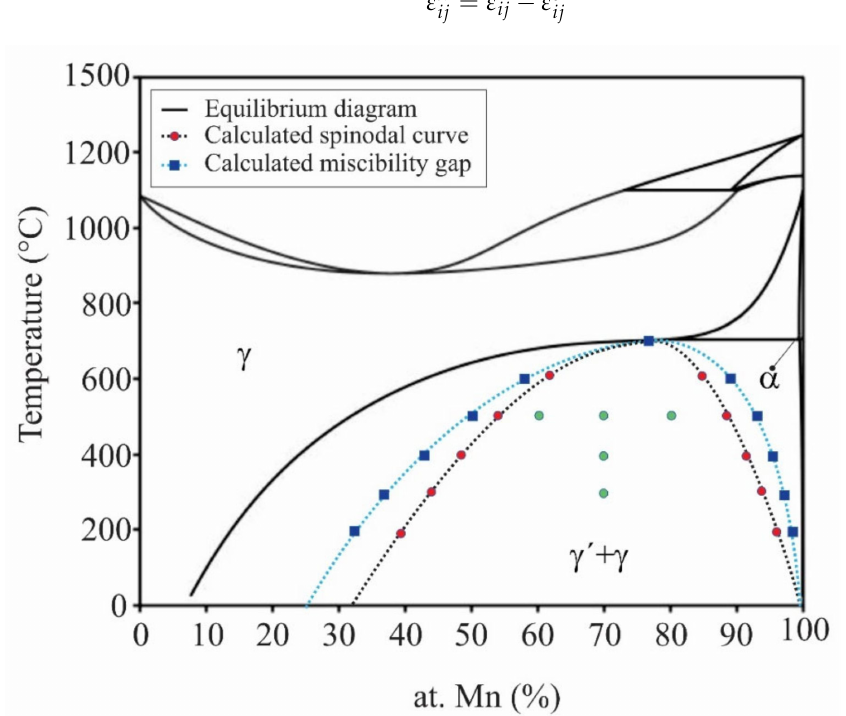
Figure 3. Equilibrium phase diagram of Mn-Cu calculated with Thermo-Calc. The blue line and marks represent the calculated miscibility gap by Wang and Lui